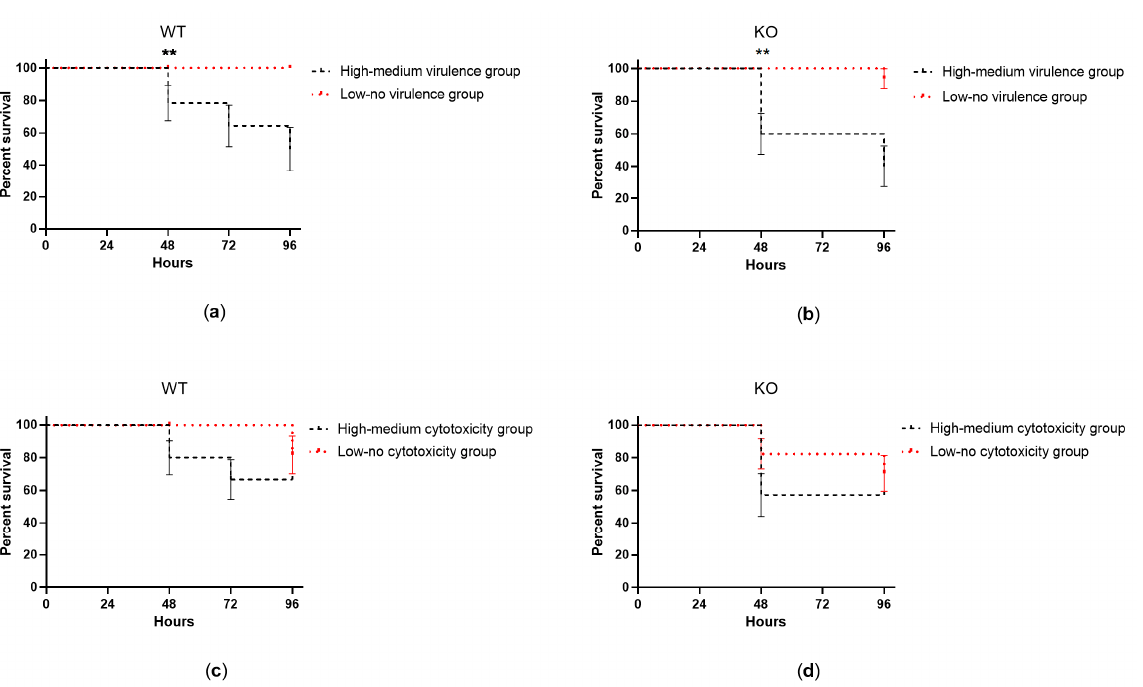
Figure 3. Percent survival of WT and KO mice up to 96 h after intratracheal challenge with clinical isolates showing ( a , b ) high–medium vs. low–no virulence in G. mellonella larvae, ( c , d ) high–medium vs. low–no cytotoxicity in human bronchial epithelial cells, and ( e , f ) high–medium vs. low–no bio fi lm formation. The mean ± SEM of 16 mice per group ( n = 4 treated with each isolate) is shown. Statistical analysis was performed by log-rank test; ** p < 0.01.